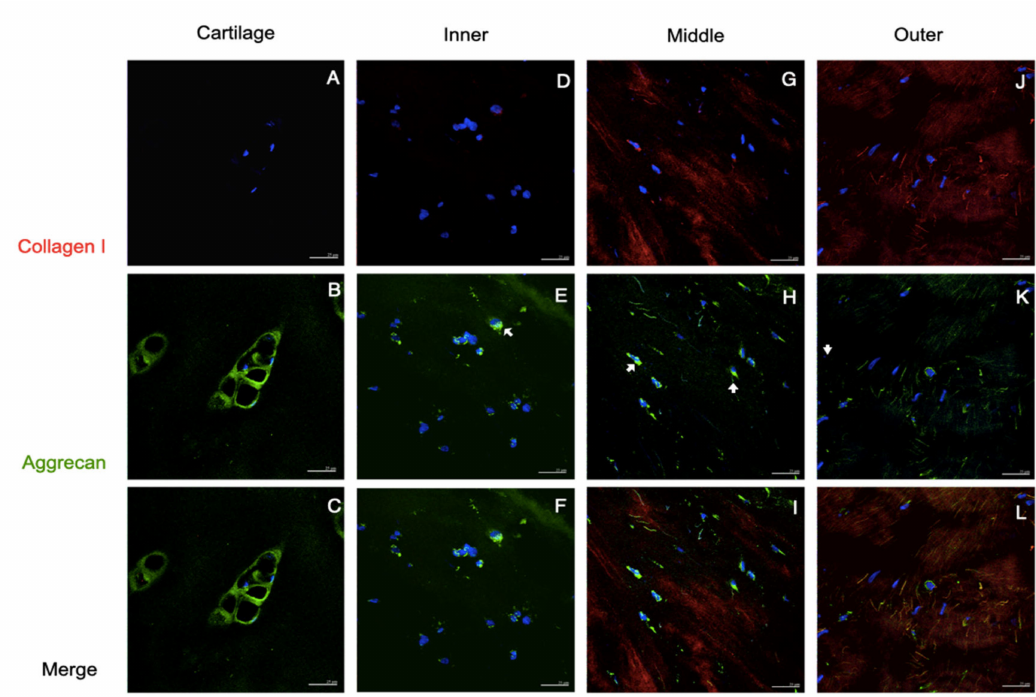
Figure 4. Collagen I and aggrecan staining of native tissues. Immunofluorescent localized Col I and Agg in human cartilage and meniscus. No positive staining of Col I was seen in the cartilage ( A ), but a tiny stain was exhibited in the inner meniscus (arrowhead in ( D )); apparently, Col I staining was detected in the middle and outer parts ( G , J ). The Agg staining obviously presented the pericellular matrix of the cartilage ( B , C ), and was scarcely displayed in three areas of the meniscus (arrows in ( E , F , H , I , K , L )). Scale bars: 25 µ